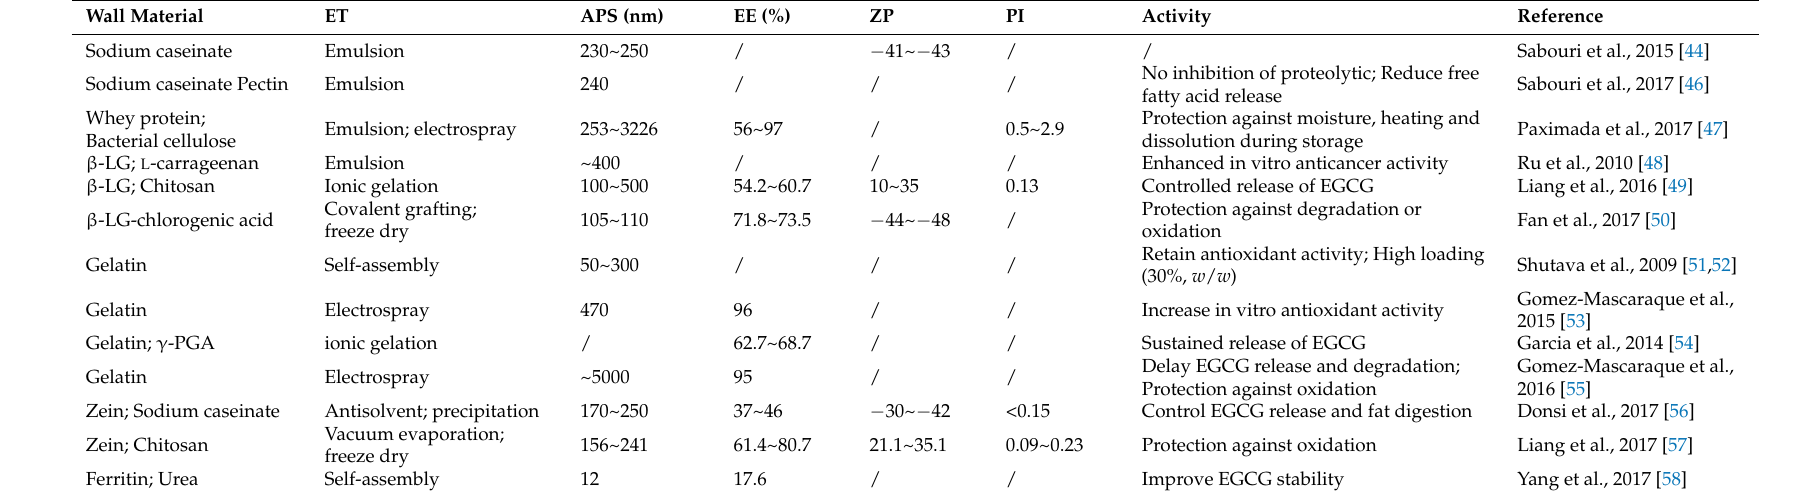
Table 1. Overview of studies on the effect of protein based encapsulation on